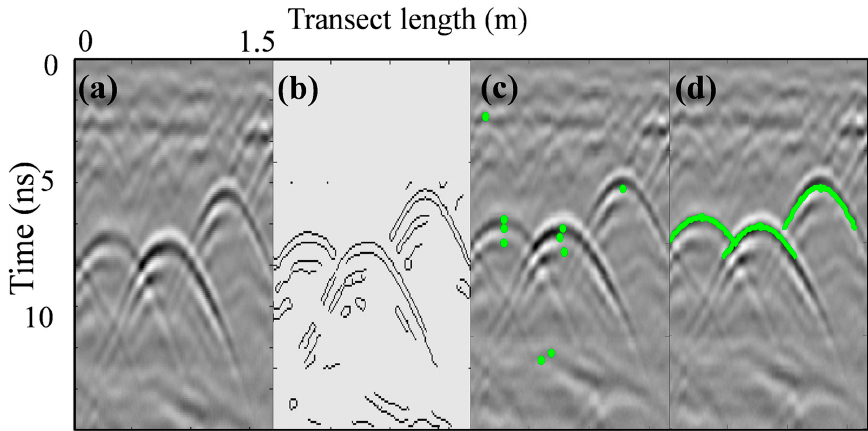
Figure 2. An example of radargram processed by the recognition algorithm based on randomized Hough transform (RHT): ( a ) radargram after pre-processing; ( b ) binary image after edge extraction, each connected edge is considered as an ROI; ( c ) results of recognition using RHT. The apexes of the recognized curves are marked with green points; and ( d ) final recognized hyperbolas with scores higher than the threshold.